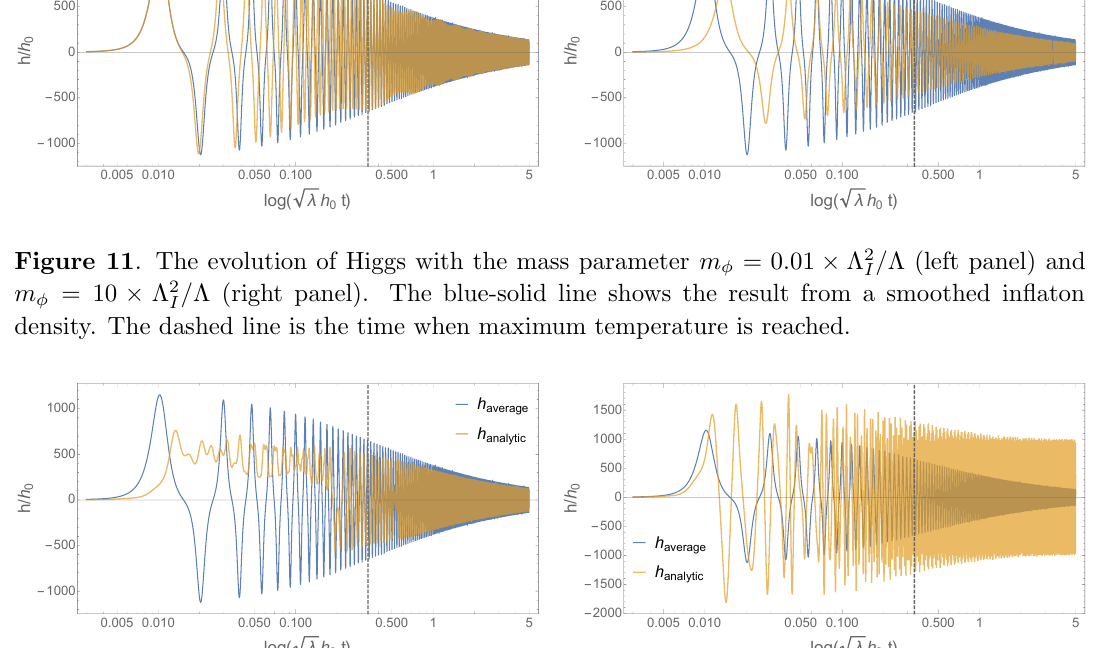
= (cid:3). The phase is chosen as I